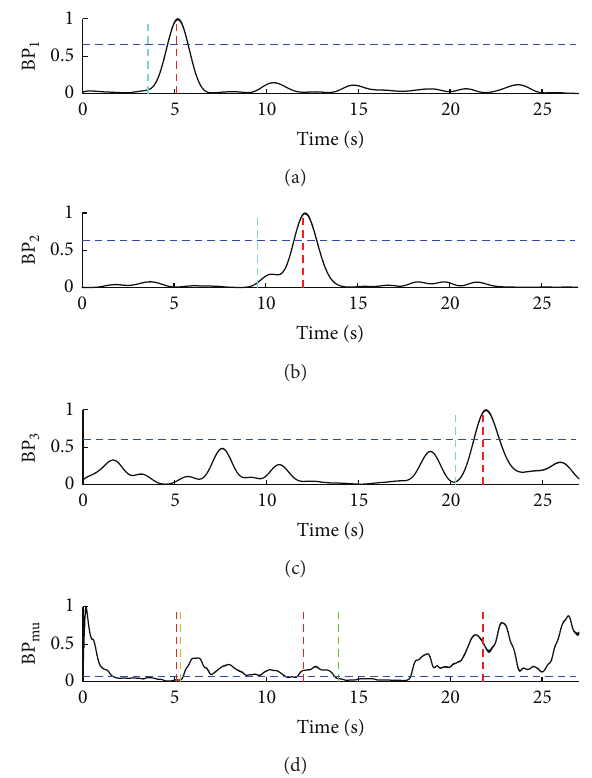
Figure 6: Normalized band-powers BP 1 , BP 2 , BP 3 , and BP mu from (a) to (d). One successful trial (TP), one false positive ERD detection (FP erd ), and one missed ERD detection (FN erd ) for subject S1, during the representative 27-second interval, are presented. (a)–(d) arrangement and color codes for tirquose, red, blue, and green are the same as in Figure 4. The yellow vertical dotted line marks one FP erd detection which occurred 200 ms after the cue for MI. FN erd occurred after the third cue for MI; that is, ERD was not detected in the following 5 seconds after the cue for MI and FES was not